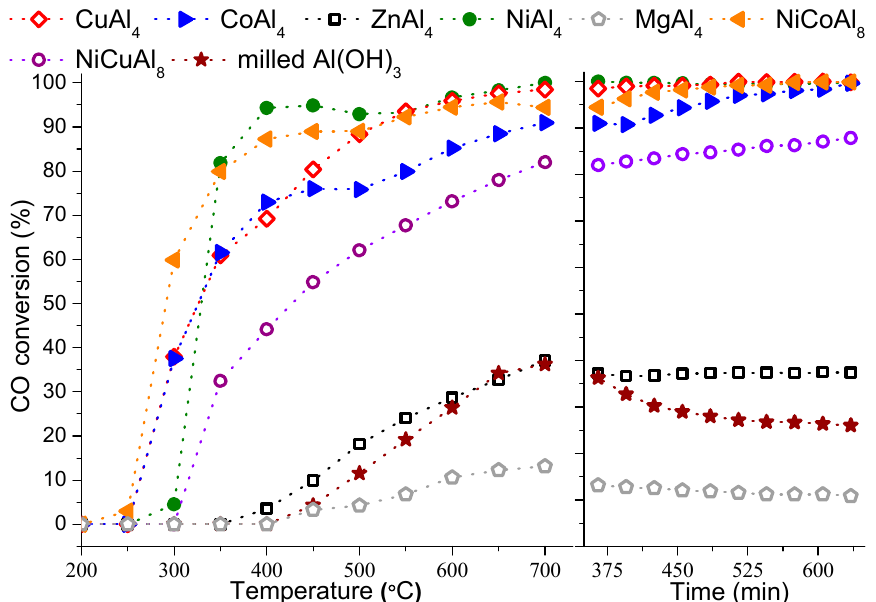
Figure 3. CO conversion values and long-term activity tests (at 700 °C) of the milled Al(OH) 3 , and the as-prepared LDHs and LTHs, at various reaction temperatures.